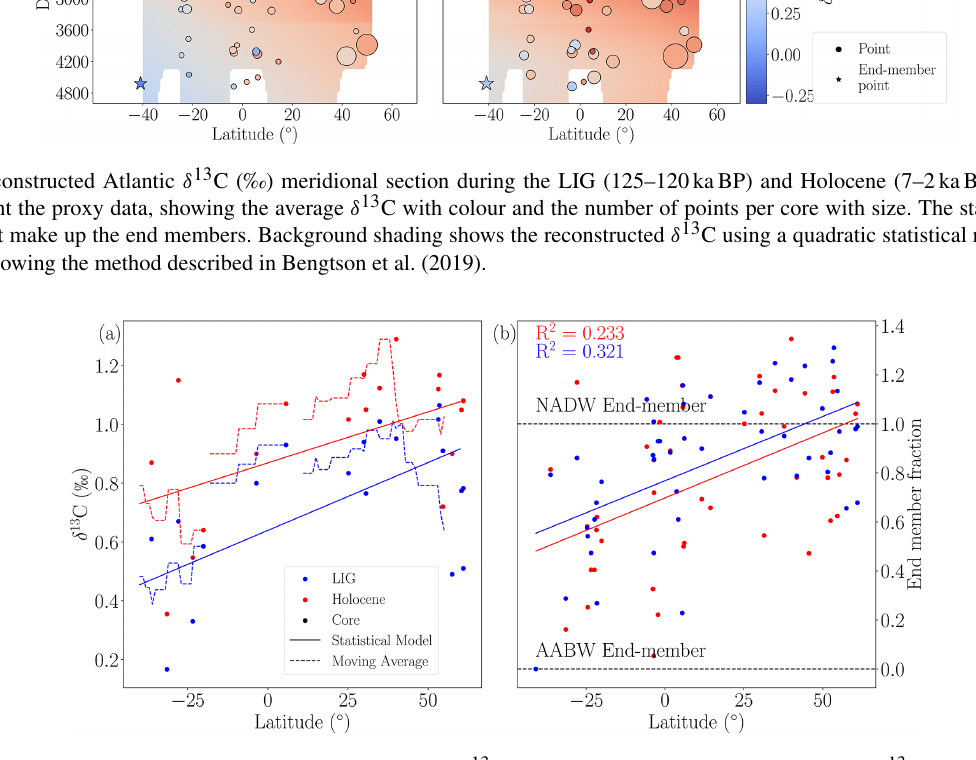
Figure 8. The meridional gradient of the Atlantic Ocean benthic δ 13 C (‰). (a) Holocene (red) and LIG (blue) δ 13 C for each core (points) between 1000 and 3000m. Dotted lines are the moving averages of the cores. Solid lines indicate the results of our statistical model at 2000m. (b) Average δ 13 C for each record deeper than 1000m as a proportion of the end members. A value of one indicates the NADW end member, and a value of zero indicates the AABW end member. Solid lines show the linear regressions of the